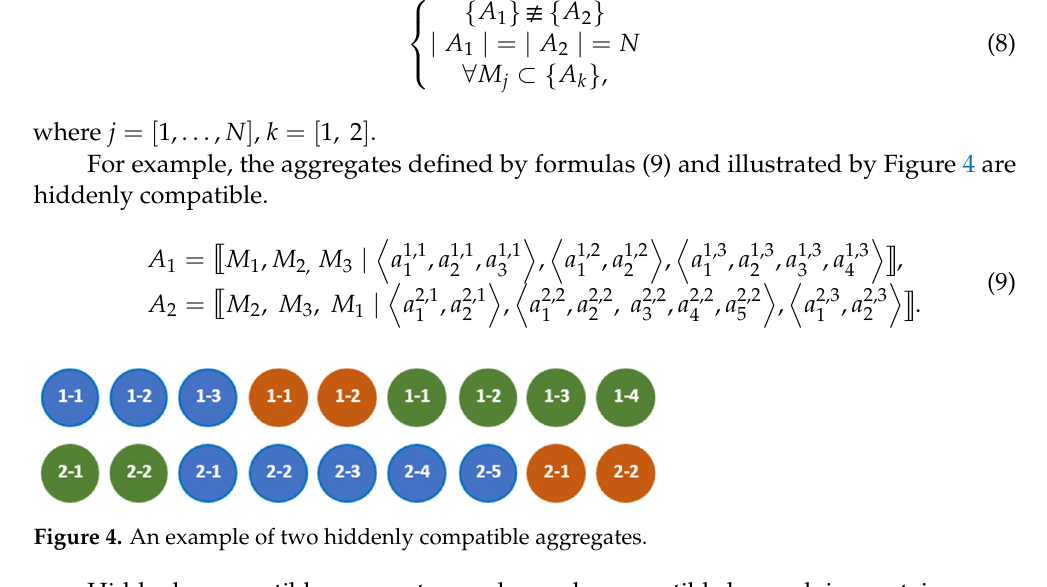
Figure 3. An example of two incompatible aggregates.